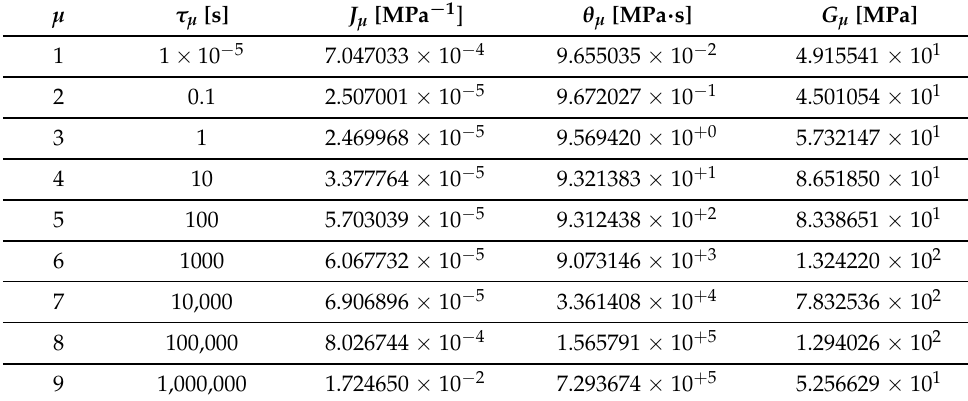
Table 5. Parameters of Maxwell chain model—L285 epoxy